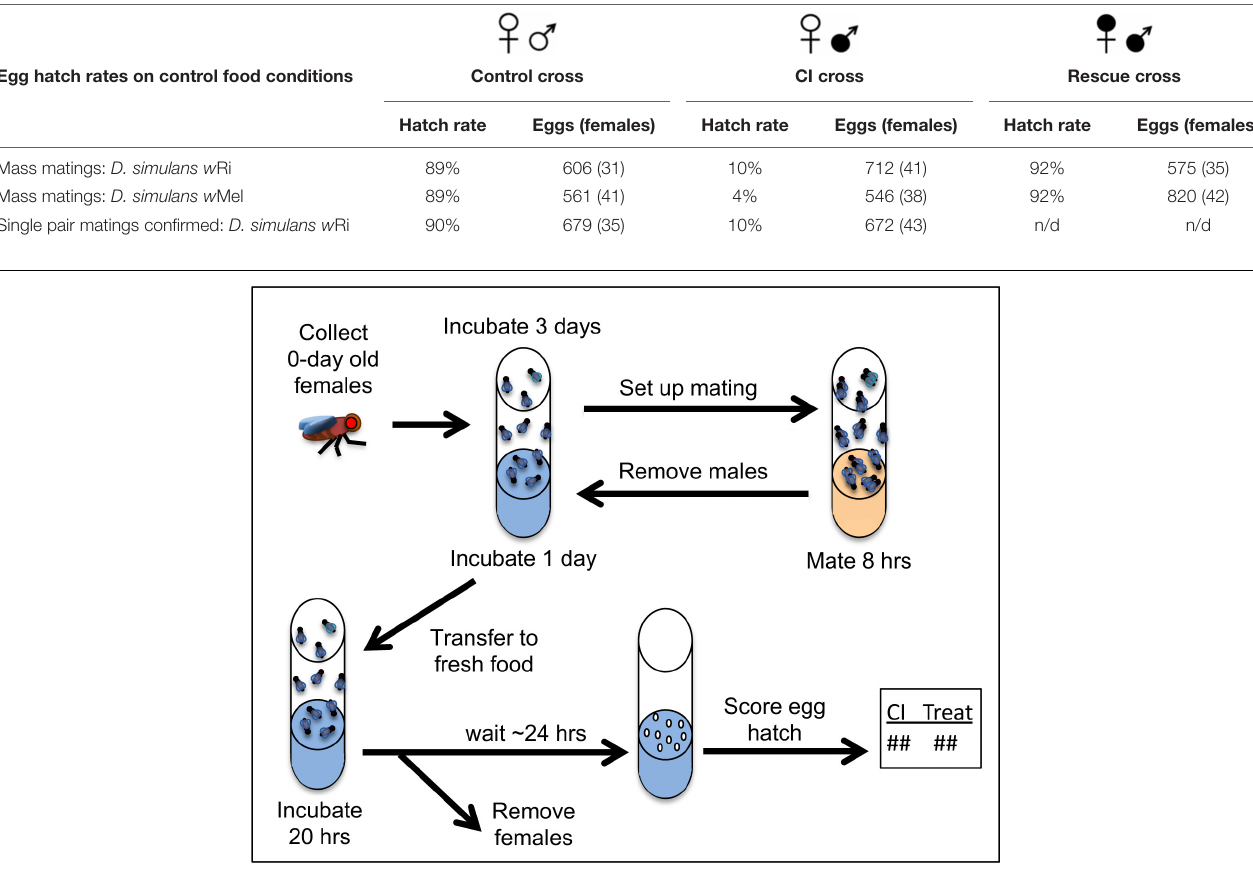
FIGURE 2 | Procedures used for CI- and Rescue-related crosses. Drug feedings were carried out on blue food where specified in the protocol timeline. For details on food preparation, please see section “Materials and Methods” and Additional File S1.